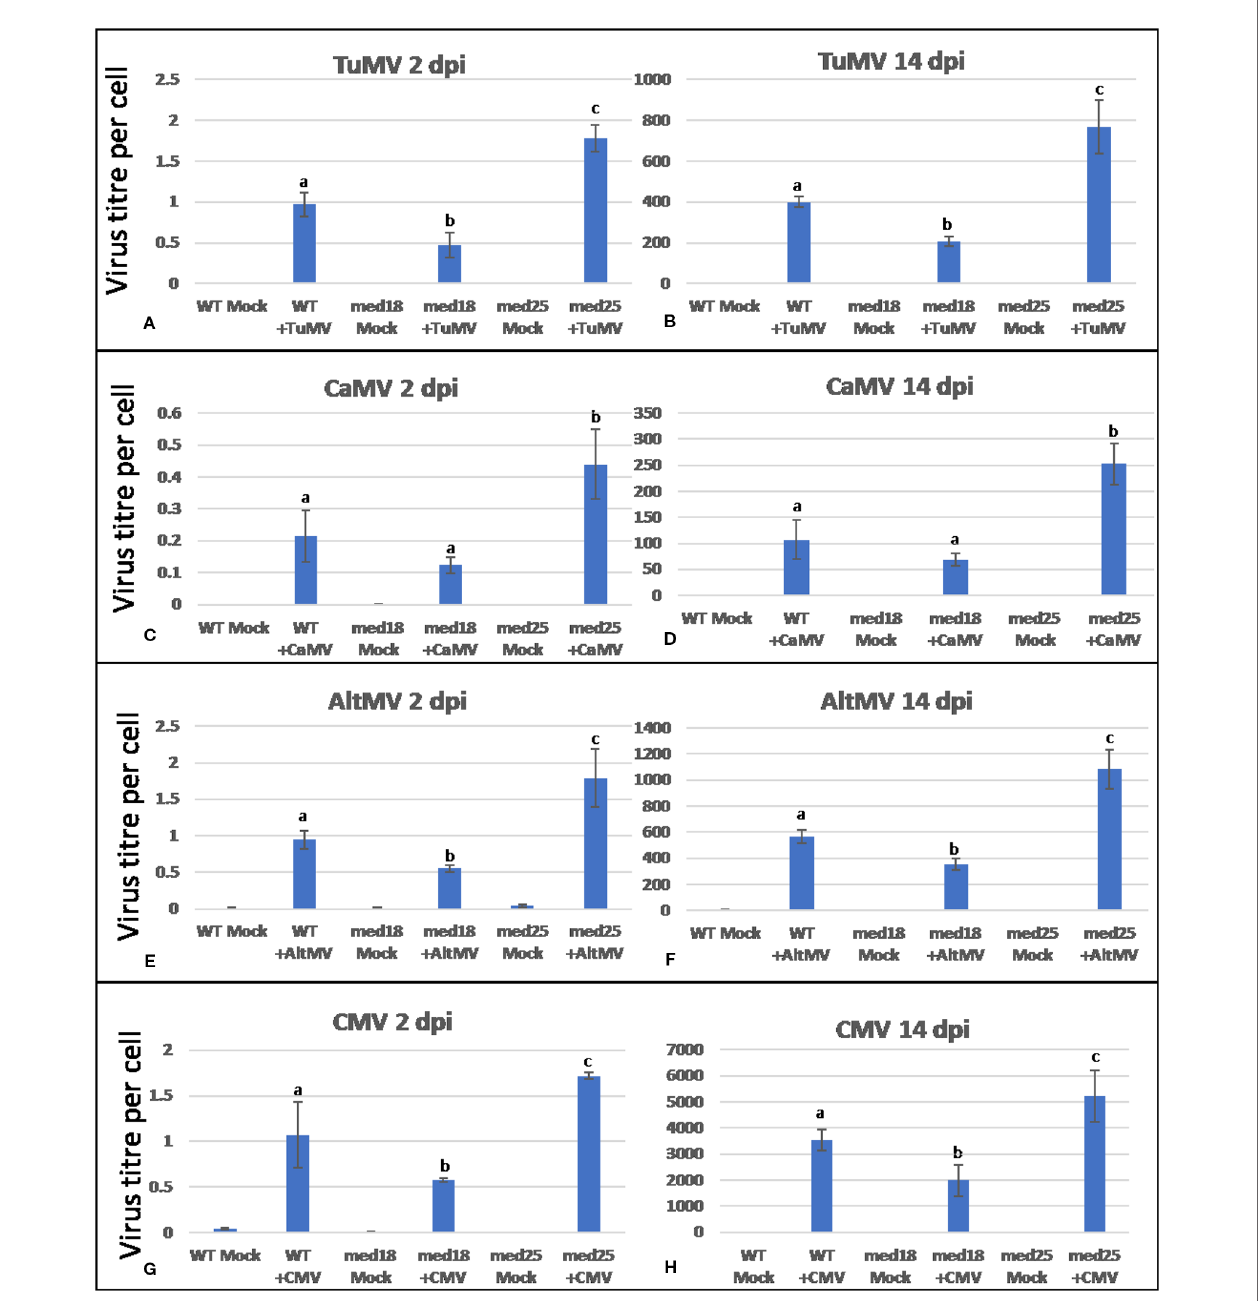
FIGURE 1 | Virus titer per plant cell of Arabidopsis wild-type ( Col -0), med18 , and med25 mutant plants inoculated with Turnip mosaic virus (TuMV) (A, B) , Cauli fl ower mosaic virus (CaMV) (C, D) , Alternanthera mosaic virus (AltMV) (E, F) , or Cucumber mosaic virus (CMV) (G, H) at 2 dpi and 14 dpi. Shown on the Y axes are quantitative reverse transcriptase PCR (qRT-PCR) or quantitative PCR (qPCR) mean values of virus abundance ± SE relative to plant cells ( ACTIN ). Different small letters indicate statistically signi fi cant ( P < 0.05) differences between genotypes of infected plants for each time point and ( VSP2, PDF1.2 ) were not differentially expressed, while SA marker gene expression ( PR1 ) was induced in the presence of CaMV at 2 dpi ( Figure 3 ). Base levels for PR1 differed for the different replicates and also across other virus experiments, but each replicate showed clear induction for PR1 following CaMV infection. To more broadly pro fi le